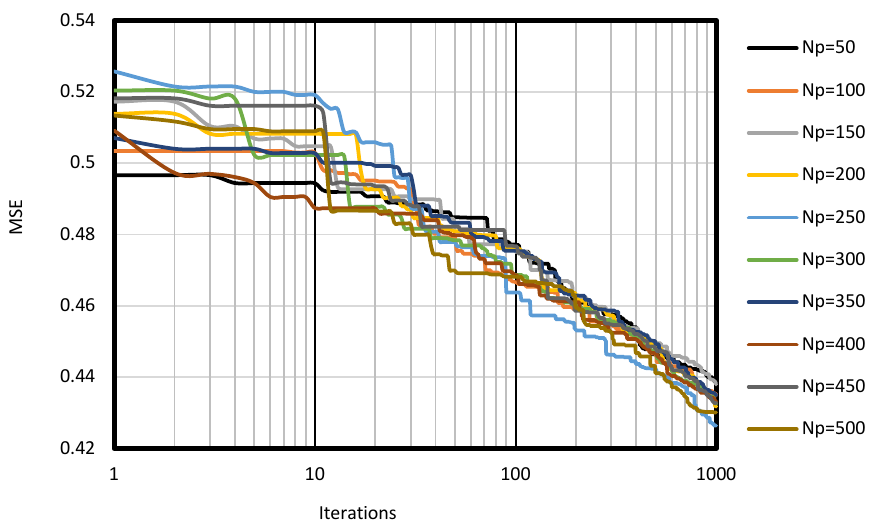
Figure 8. The variation of mean squared error as a function of iterations was acquired as from sug- gested BSAMLP architectures for forecasting flood vulnerability mapping.